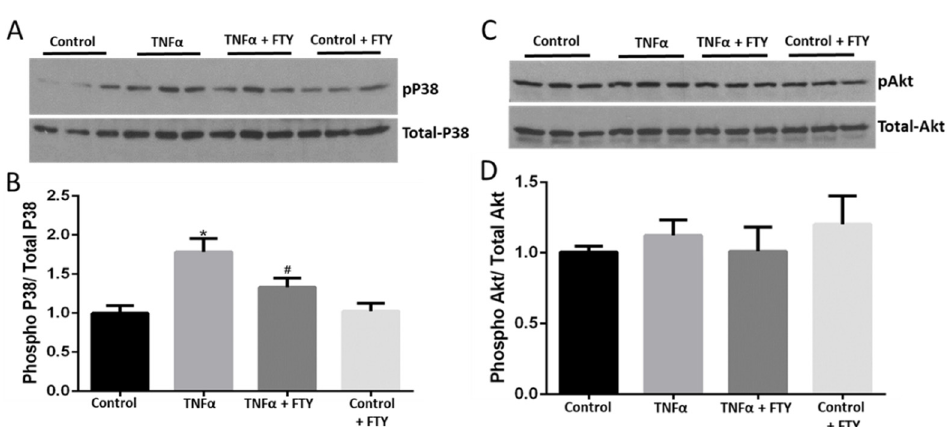
Figure 2. Fingolimod co-treatment mitigates TNF α -induced activation of cellular stress signaling. ( A ) Western blot images showing upregulation of phospho-p38 MAPK levels in response to TNF α (10 ng/mL) treatment in R28 cells, which was reduced in the presence of FTY. ( B ) Bar graph showing band densitometry quantification of Western blots indicating the effects of FTY in suppressing P38 MAPK activation induced by TNF α treatment [ n = 6; * p < 0.05 vs. Con; # p < 0.05 vs. TNF α ]. ( C ) Western blot images showing no changes in phospho-Akt (Ser473) levels in response to either TNF α (10 ng/mL) and/or FTY in R28 cells. ( D ) Bar graph showing band densitometry quantification of Western blots indicating the no changes in phospho-Akt (Ser473) levels in response to either TNF α (10 ng/mL) and/or FTY in R28 cells [ n = 6; NS vs. TNF α ].